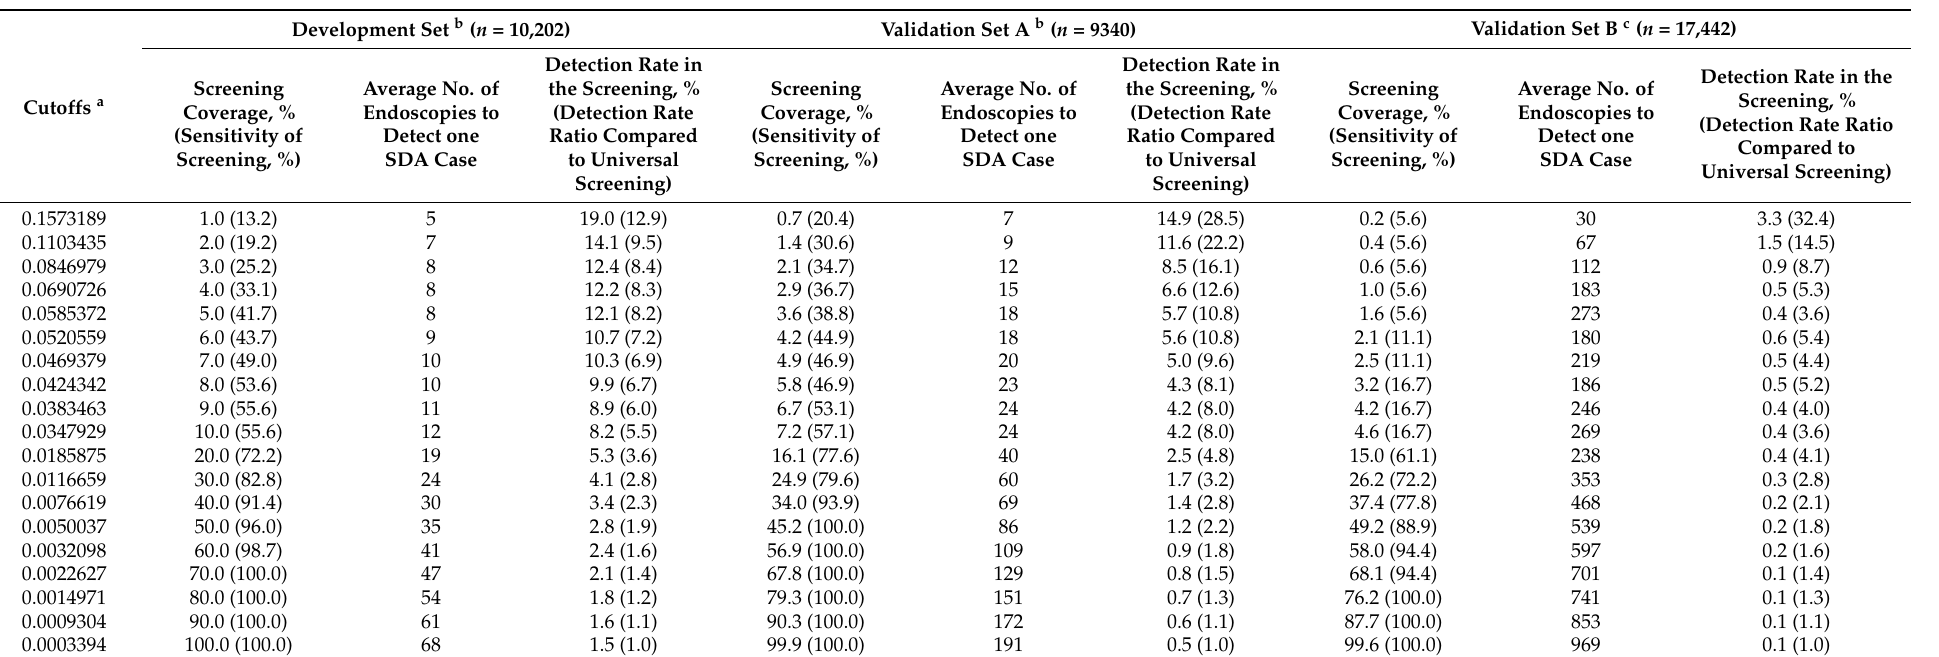
Table 3. Evaluation of application performance of the prediction model for different screening coverages to detect severe dysplasia and above (SDA)